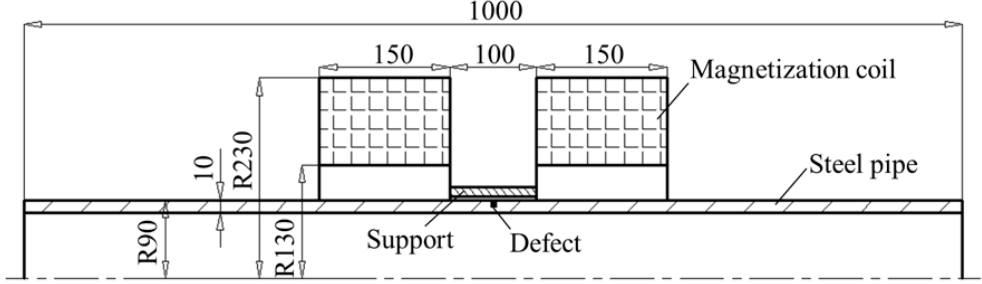
Figure 4. The simulation model of MFL testing for steel pipe.